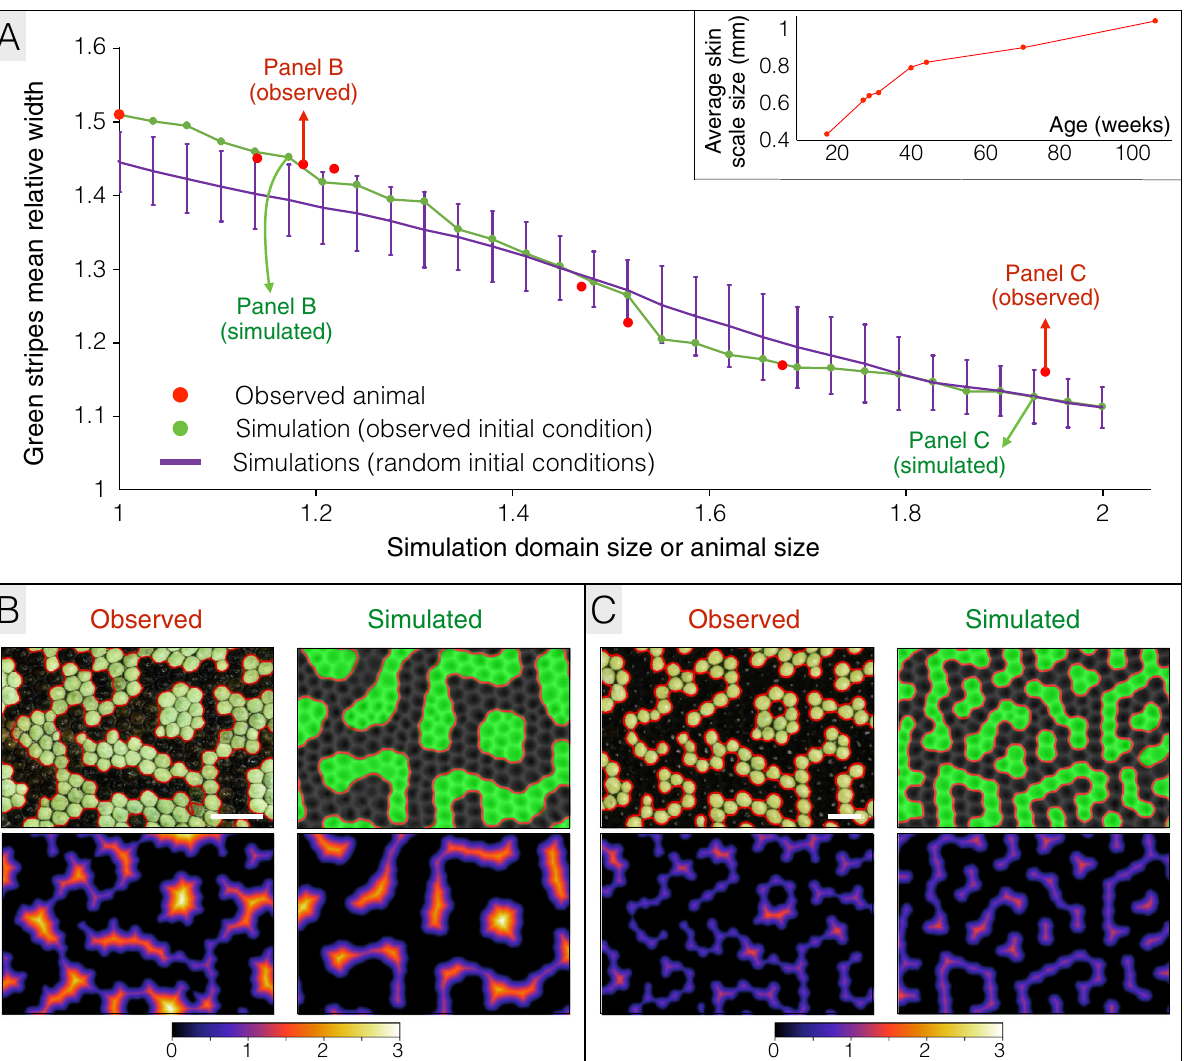
Fig. 5 Growth affects patterning dynamics. A Growth (inset: growth curve of the animal) causes a monotonous decrease in the mean relative length scale of the pattern both in the real animal (red spots = 18, 28, 30, 32, 41, 45, 71 and 106 week-old animal) and in a quasi-static growth simulation (green line; initial condition = 18-week-old observed pattern). The purple line shows the time evolution of the pattern mean length scale averaged among 20 independent simulations starting form different random initial conditions (30% randomly-distributed black skin scales); error bars = 3 standard deviation intervals. Simulations were performed in 2D by applying dimensionality reduction on the 3D chromatophore domain (Fig. 3D). The size of simulation domains is normalised to the skin patch size at 18 weeks. B , C Comparisons between real and simulated patterns for normalised domain sizes of ≈ 1.15 ( B ) and ≈ 1.95 (C). Top panels show the patterns with detected borders (indicated in red) and bottom panels show the distance (expressed in average skin scales) of each green scale to the border. The observed and simulated patterns both exhibit green labyrinthine stripes that are 2 – 3 and 1 – 2 skin scales wide in B and C , respectively. Scale bars = 2 mm. Time evolution of the pattern length scale is also illustrated in Supplementary Movie